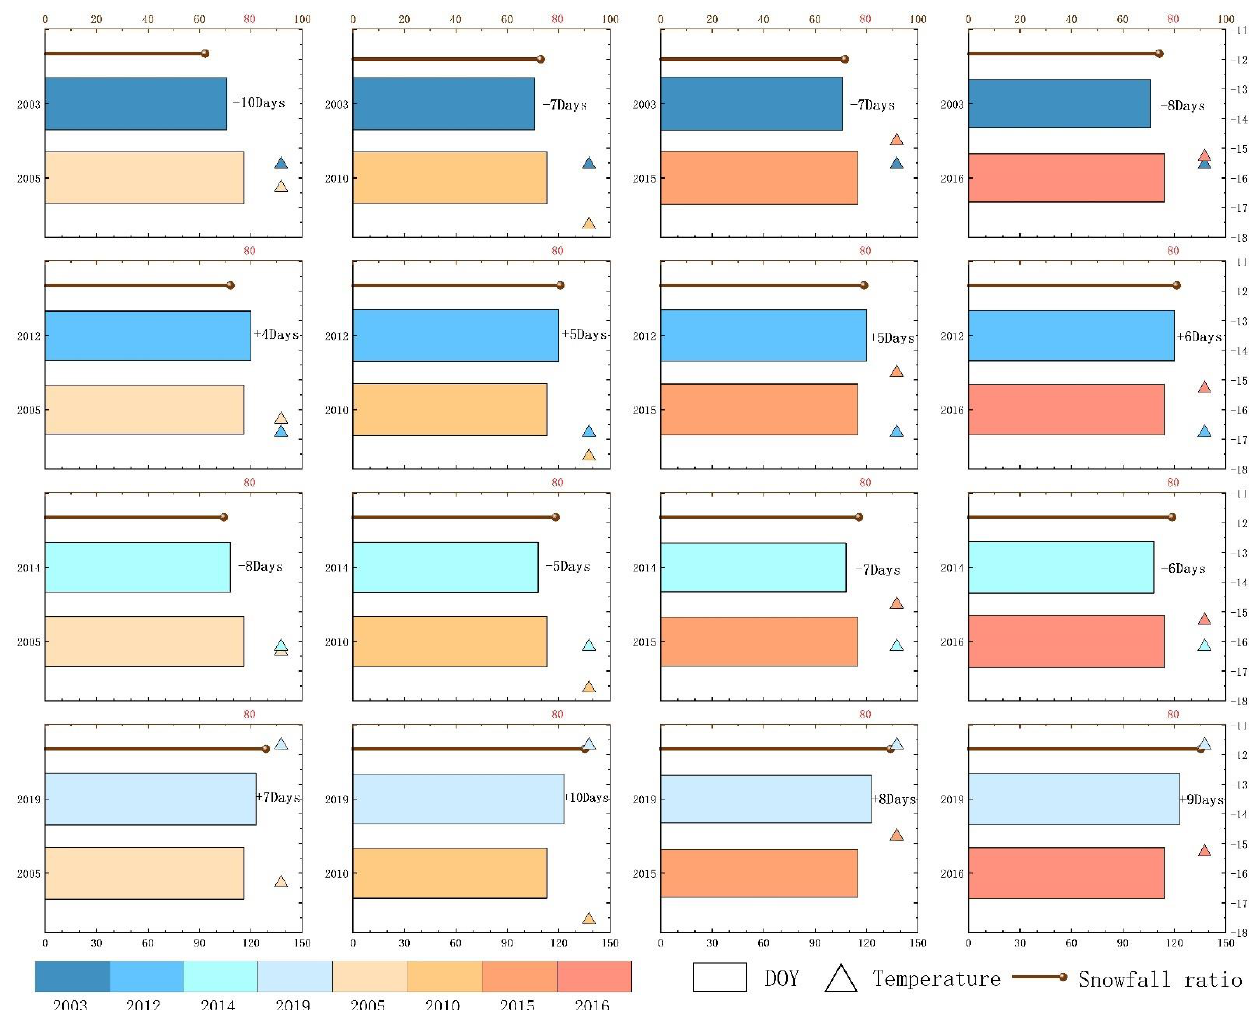
Figure 7. The grassland SOS by year of date in the Sanjiang Plain. The left axis is the year, the right axis is the temperature (°C), the upper axis is the snowfall ratio, and the lower axis is the DOY of each year’s SOS. Rectangles represent the DOY of SOS, triangles represent the temperature, and lines represent the snowfall ratio.